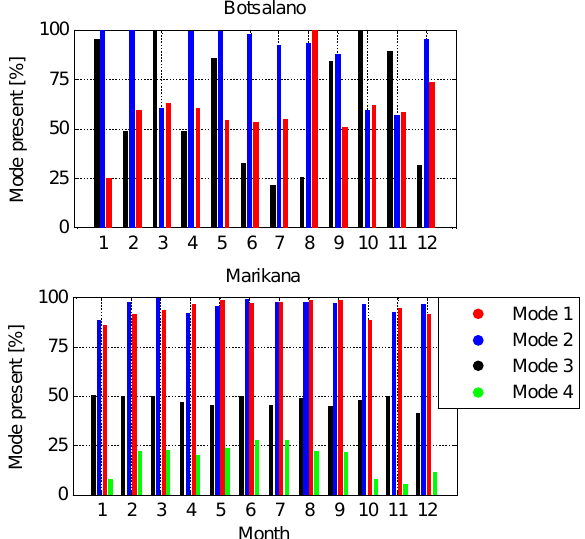
Fig. 10. Monthly frequency of occurrence of each mode in Bot- salano (upper panel) and Marikana (lower panel). The frequency is based on modal fits to the monthly median diurnal plots in Ap- pendix A.